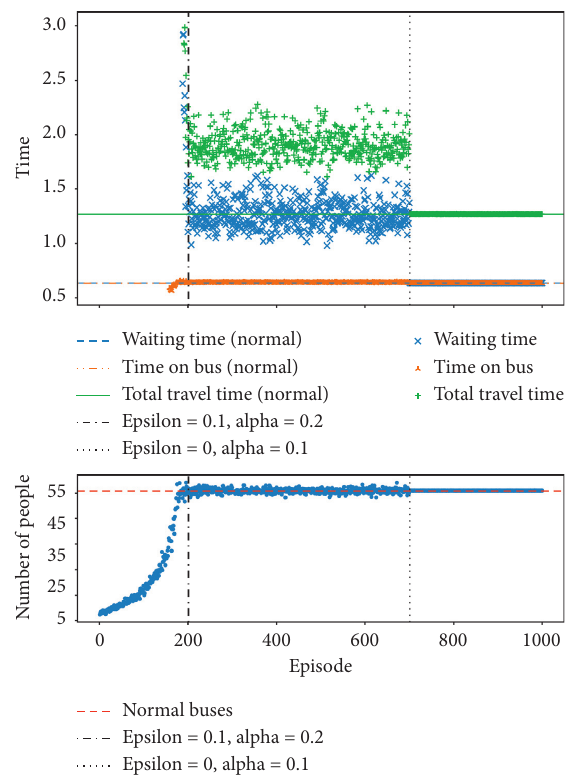
Figure 2: A bus serving a loop of bus stops learns to be a bus by reinforcement